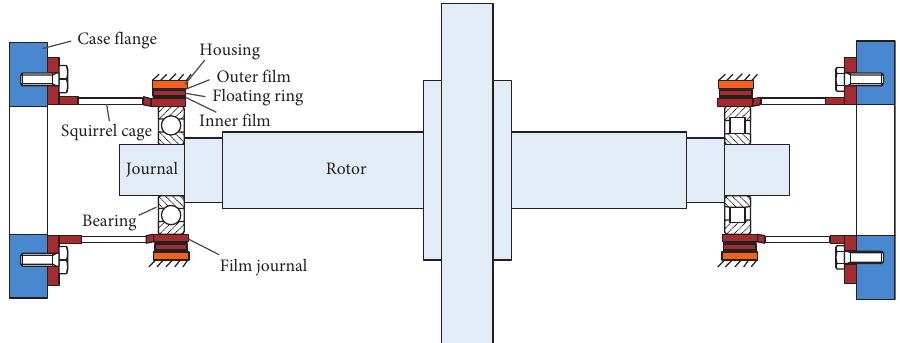
Figure 6: The schematic diagram of rigid rotor with squirrel cage and DCSFD.